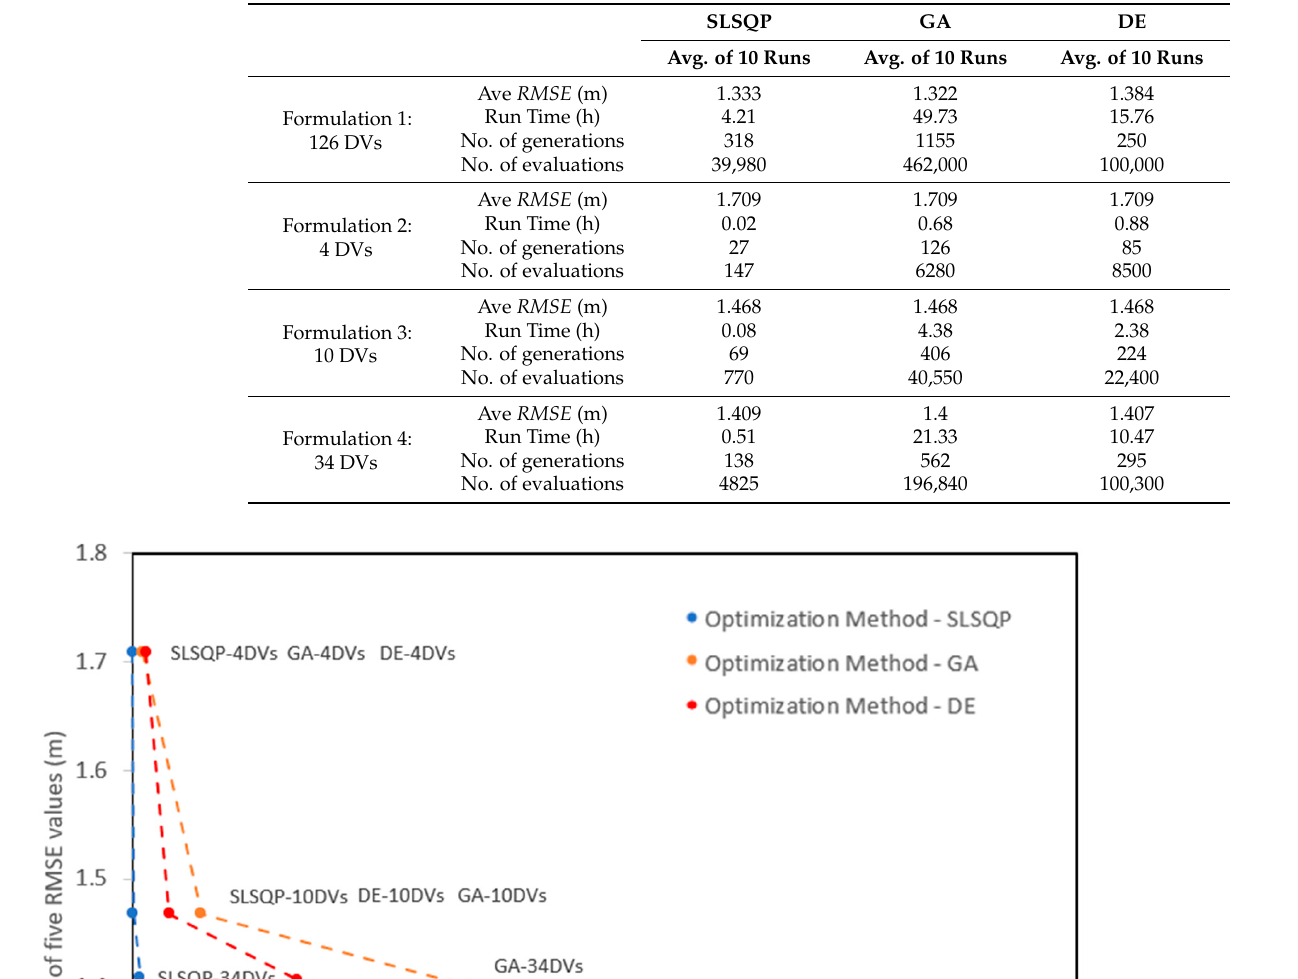
Table 3. Optimization results obtained from three optimization methods and four decision variable set formulations.